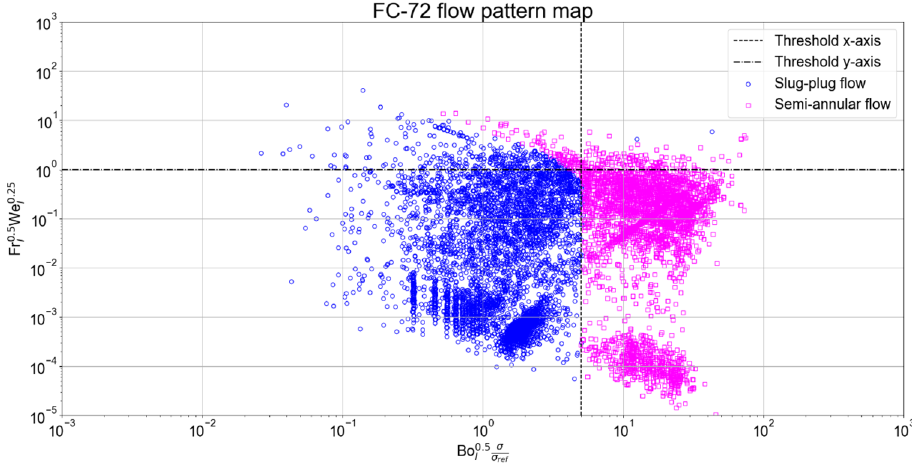
Figure 10. Updated flow pattern map for FC-72: multilayer perceptron.